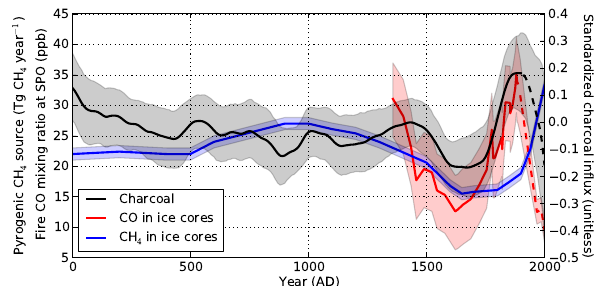
Fig. 1. Variability of biomass burning rates over the last centuries based on a worldwide compilation of charcoal records (Marlon et al., 2008), CO mixing ratios from fires using CO concentration measurements at the South Pole (SPO), its isotopic signature, and a mass balance model (Wang et al., 2010), and a similar approach but based on CH 4 (Ferretti et al., 2005). The CO ice core data ended in 1897 but was extended (dashed line) by Wang et al. (2010) to present-day using firn samples (1968 and 1986) as well as mod- elling (year 2000). Shaded areas indicate reported uncertainty. Note that the datasets have different footprints and that absolute values cannot be compared